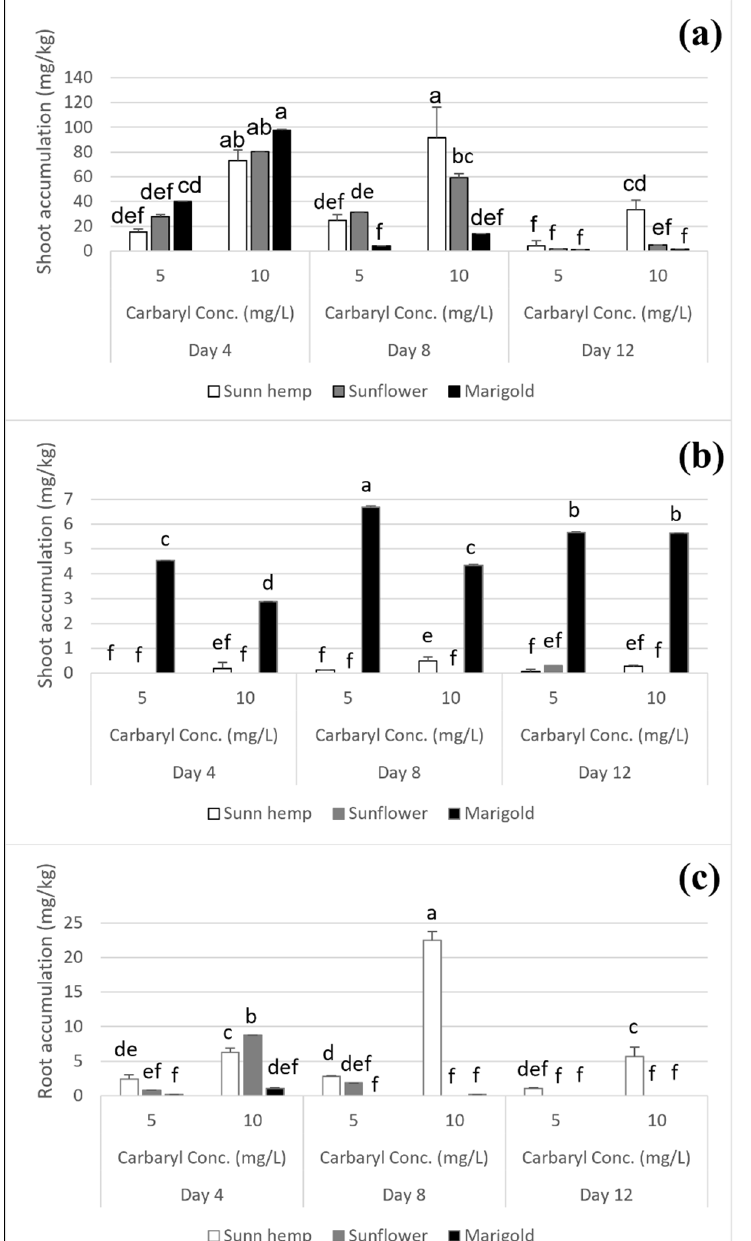
Figure 7. Carbaryl degradation in shoots and roots of sunn hemp, sunflower, and marigold after 4, 8, and 12 days of cultivation; carbaryl in shoots ( a ), 1-naphthol in shoots ( b ); and carbaryl in roots ( c ). Note: a, b, c, d, e, and f indicate significant differences based on ANOVA and Tukey's HSD test. The data shown are mean and SD.